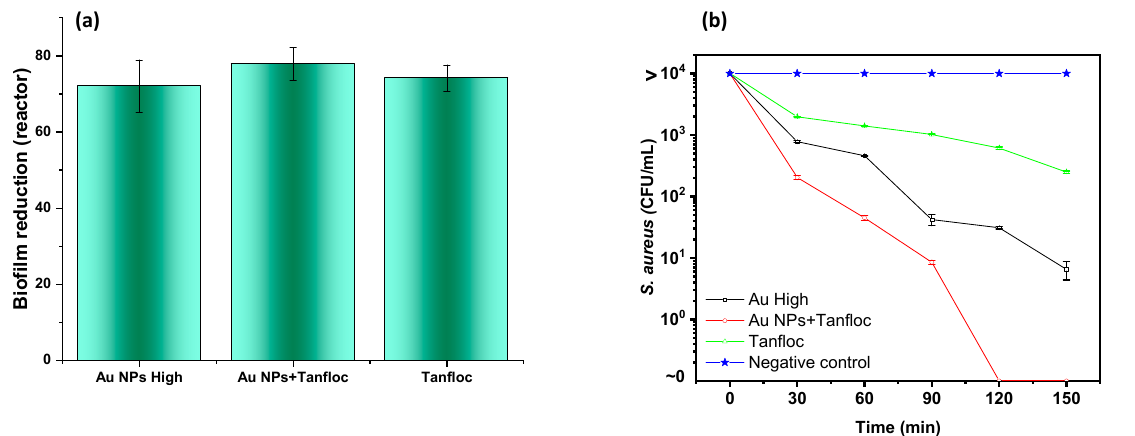
Figure 6. ( a ) Antibiofilm activity of the compounds based on Tanfloc and gold nanoparticles against S. aureus and ( b ) kill-time assays of experimental systems against S. aureus provided by experimental systems (Au NPs High, Au NPs + Tanfloc, Tanfloc and negative control).